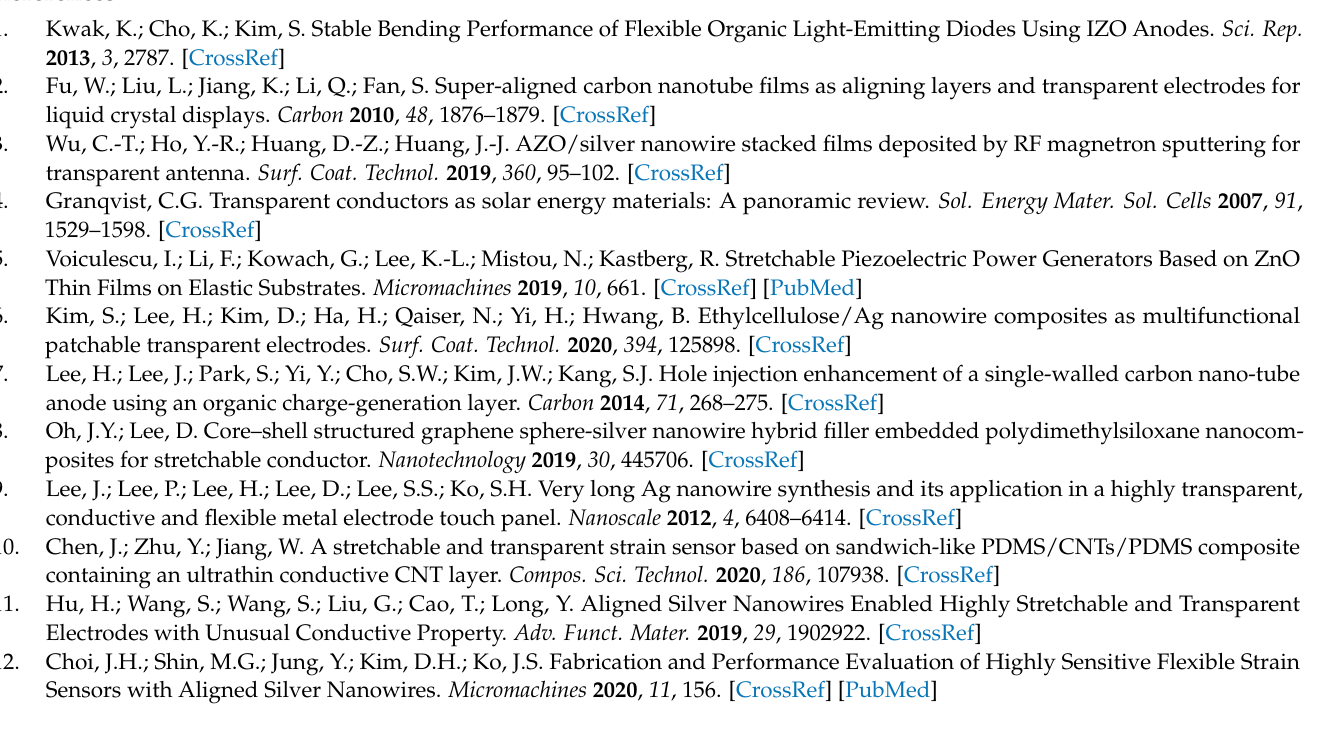
and DLG. Figure S2: ( a ) Raman spectra and ( b ) I2D/IG ratios of nine measuring points for SLG; ( c ) Raman spectra and ( d ) I2D/IG ratios of nine measuring points for DLG. Figure S3: ( a ) UV-Vis spectra and ( b ) transmittances of nine measuring points at 550 nm for SLG; ( c ) UV-Vis spectra and ( d ) transmittances of nine measuring points at 550 nm for DLG. Figure S4: Top-view SEM image of the